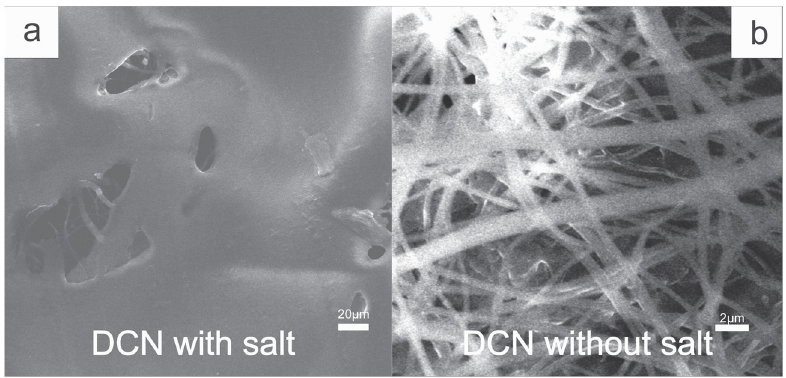
Figure 5. SEM images of dyed cellulose fibers (DCN) with salt ( a ) and without salt ( b